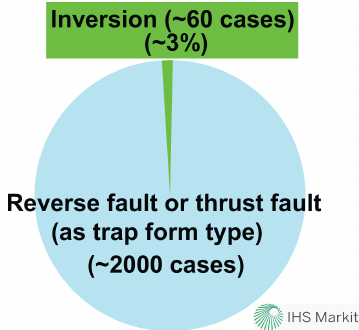
Figure 2. Outcome of a worldwide (excluding onshore US and Canada) database search using hydrocarbon fields and discoveries with circa 2000 reservoir units. In these reservoir units the “trap form” type was classified as reverse fault or thrust fault. Interest- ingly, within these 2000 cases we have found only about 60 matches for inversion as a trap-forming mechanism. This translates into only about 3%, a strikingly low proportion. We believe that inversion tectonics may be unrecognized in many fields globally, and there- fore it remains underreported. Courtesy of IHS